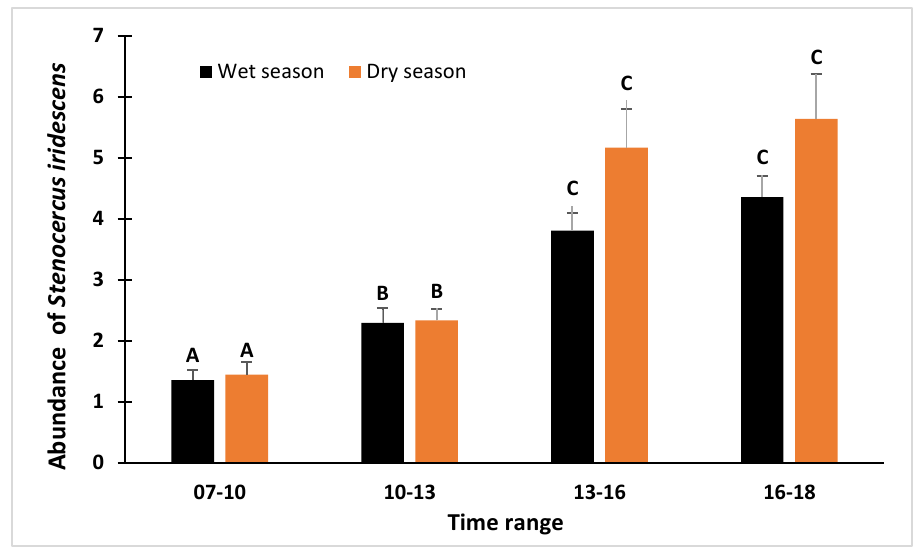
Figure 2. Abundance of Stenocercus iridescens expressed as the number of individuals observed per transect during the four time ranges for the dry and wet season separately. Error bars represent the standard error. Different uppercase letters indicate significant differences among time ranges according to the post hoc tests ( p -value < 0.05) for the wet and dry season separately. Table 1. Best candidate models explaining the number of individuals according to the AIC criteria for the dry and wet season separately. Only candidate models ( ∆ AIC < 2) are shown. k = number of parameters.